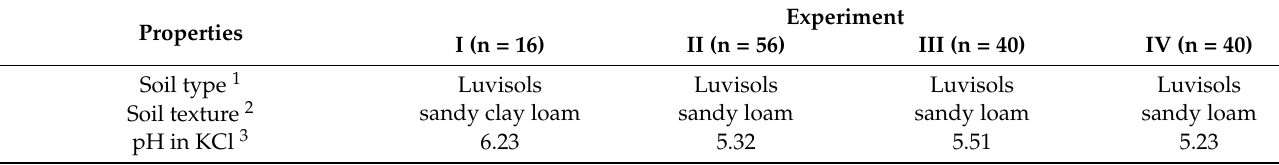
Figure 1. Study site location. Table 6. Soil characteristic before the start of the